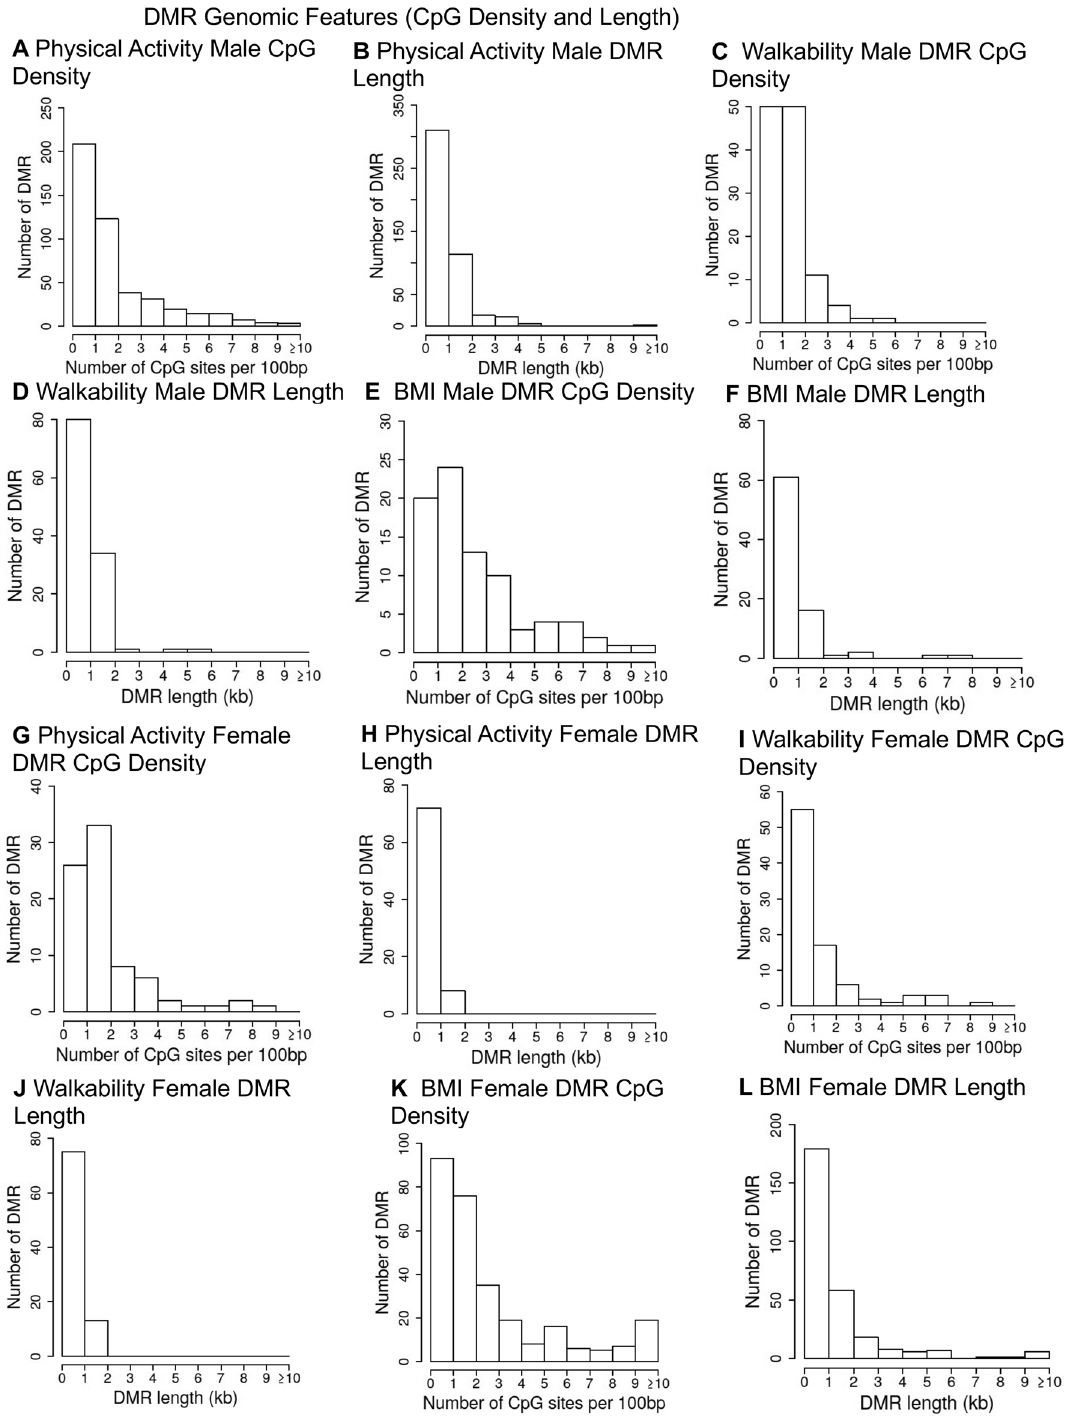
Figure 4. DMR genomic features CpG density and length. ( A ) Activity male CpG density; ( B ) Activity male DMR length; ( C ) Walkability male CpG density; ( D ) Walkability male DMR length; ( E ) BMI male CpG density; ( F ) BMI male DMR length; ( G ) Activity female CpG density; ( H ) Activity female DMR length; ( I ) Walkability female CpG density; ( J ) Walkability female DMR length; ( K ) BMI female CpG density; and ( L ) BMI female DMR